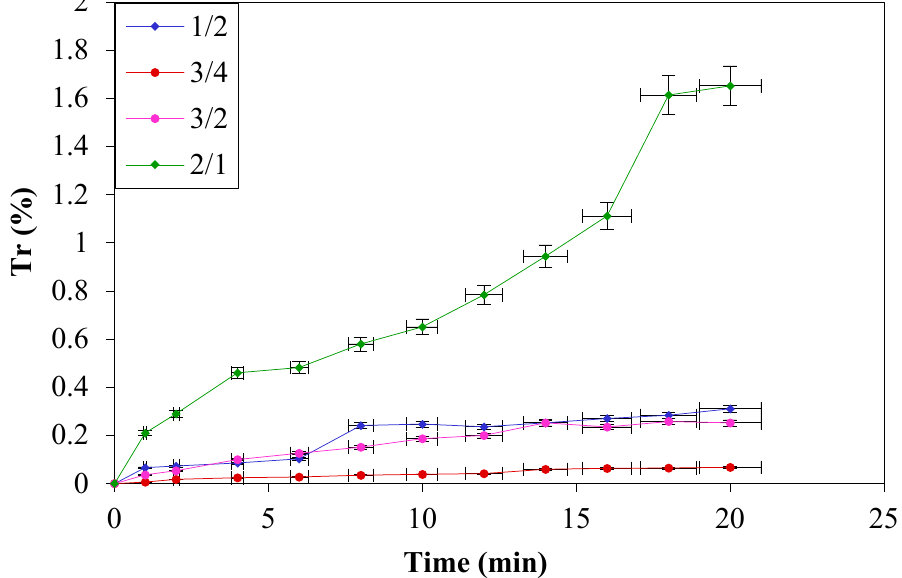
Figure 6. Effect of the volume ratio of internal phase to organic phase (CSpan 80: 2% wt./wt., w: 250 rpm, int/org ( v / v ): [1/1–2/1], emu/ext ( v / v ): 0.15/1, t emuls = 3 min, [HNO 3Internal phase ]:0.5M).